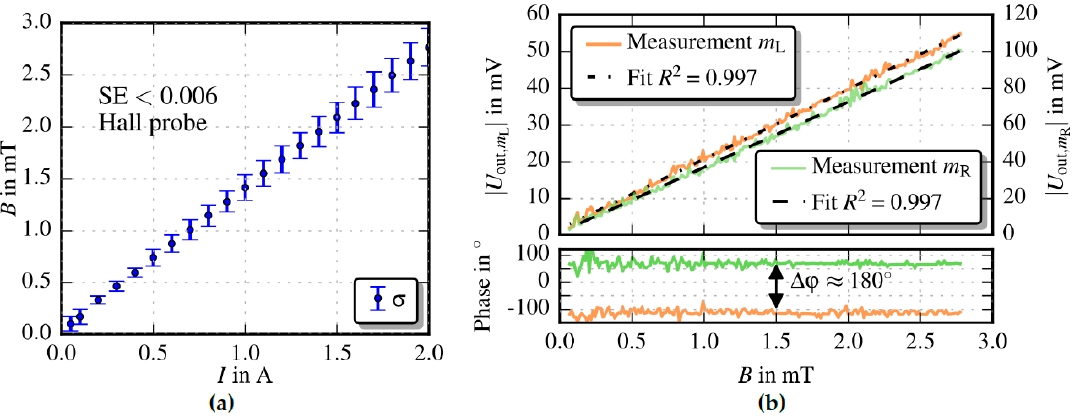
Figure 3. ( a ) The generated magnetic field in dependency of the coil current, characterised by a Hall probe (Teslameter, AS-NTM-2)). ( b ) Sensor output signals depending on the applied B -field. A phase difference of 180° denotes that both masses oscillates in the same direction which is equal to a unidirectional B